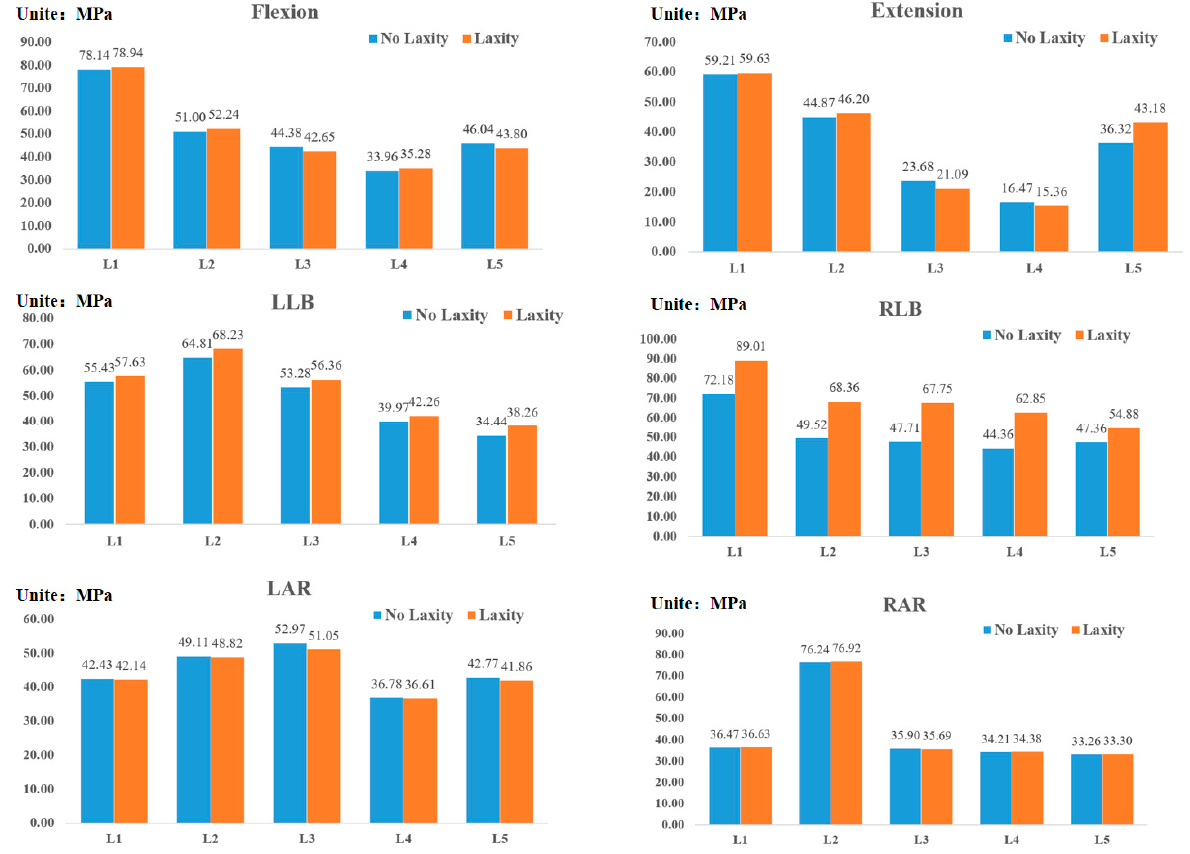
Figure 3. The maximum stress value of the vertebral body under each load.